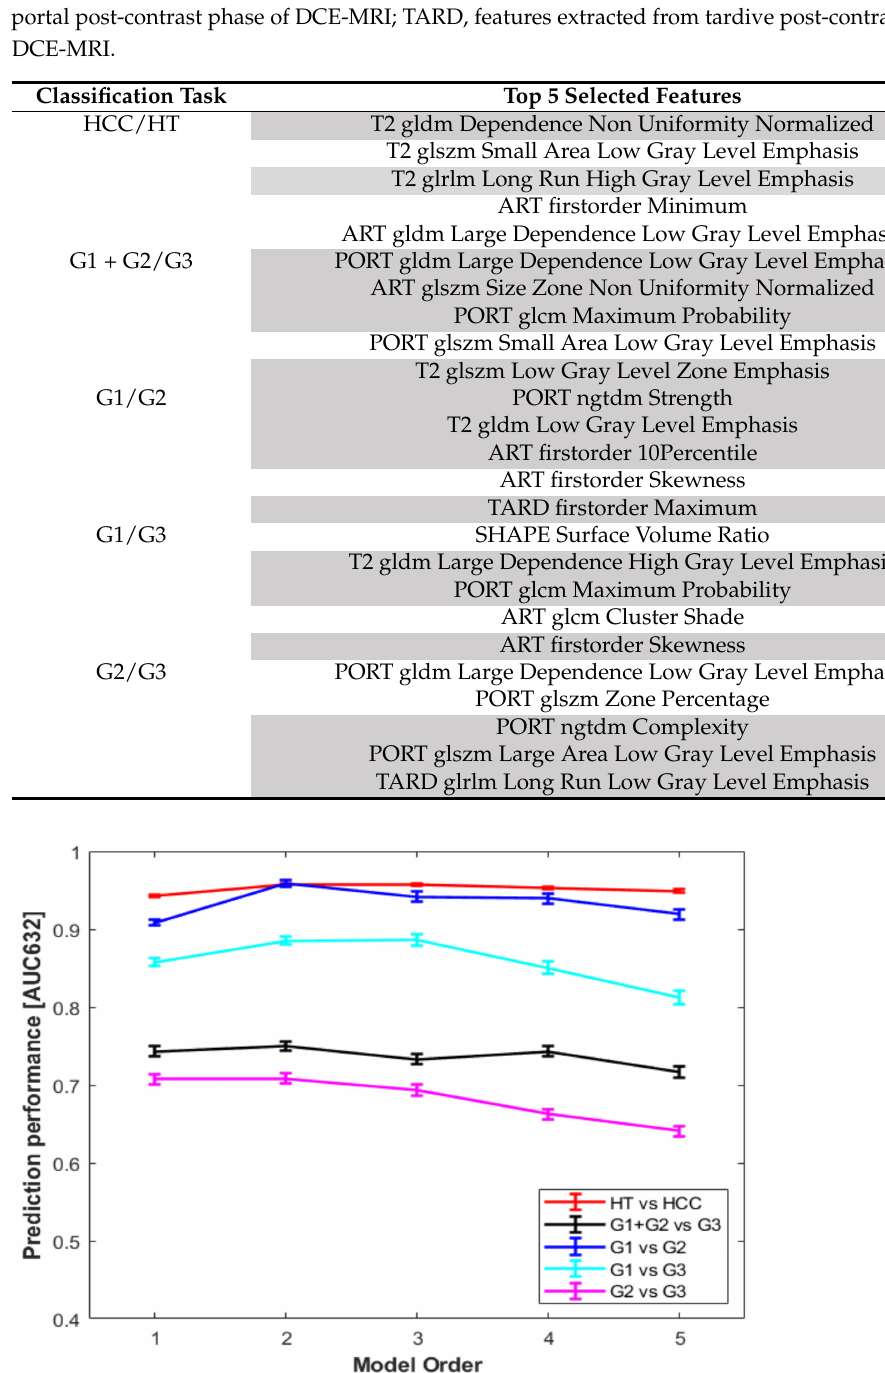
Figure 5. Prediction performances in terms of 0.632+ AUC of models from order 1 to 5 for each classification task. Abbreviations: HCC, hepatocellular carcinoma; HT, normal liver parenchyma; G1, well-differentiated HCC; G2, moderately differentiated HCC; G3, poorly differentiated HCC; AUC, area under the receiver operating characteristic